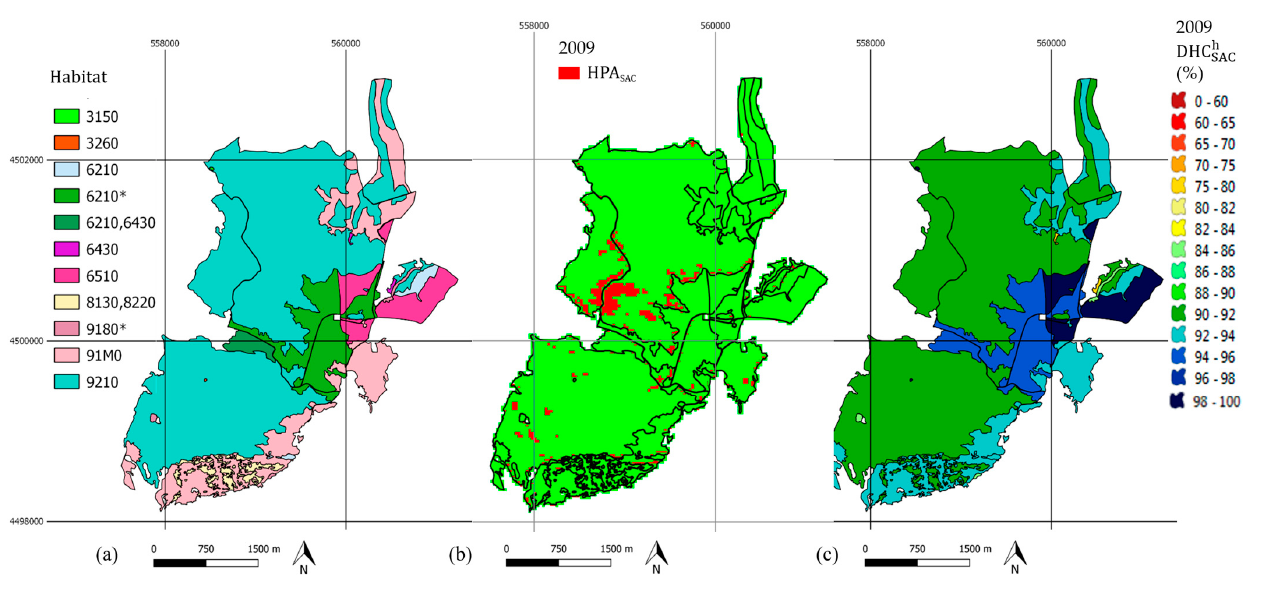
Figure 6. Monti Li Foi SAC: ( a ) Map of habitats; ( b ) map of habitat priority areas; ( c ) map of the degree of habitat consistency (DHC) index. Maps ( b , c ) are obtained on the statistics of 2009 data at SAC level.